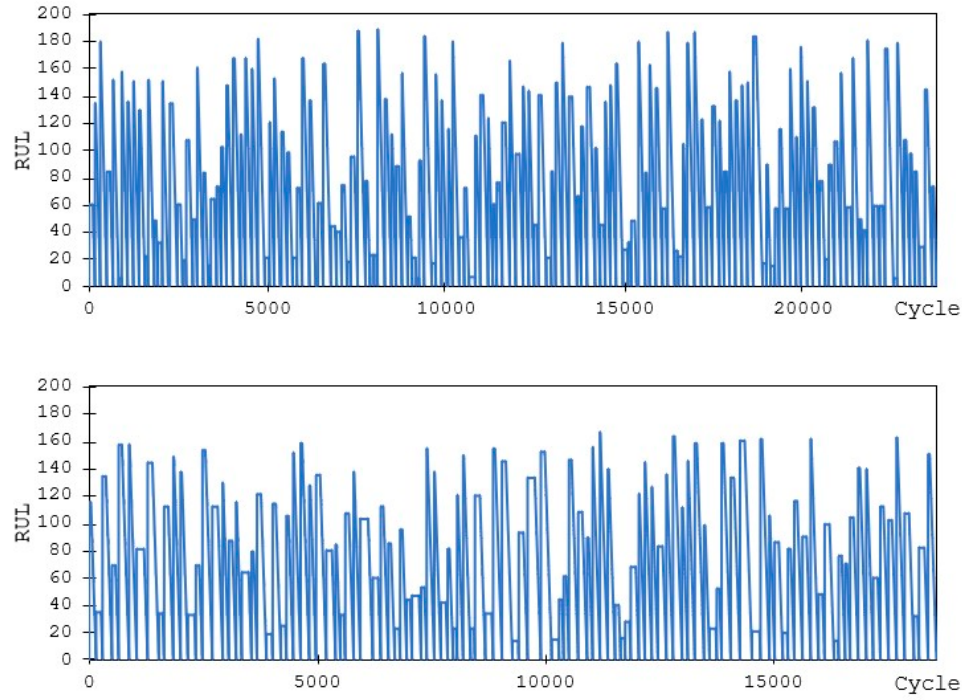
Figure 8. RUL curve of all testing engines: FD002 ( top ) and FD004 ( bottom ).